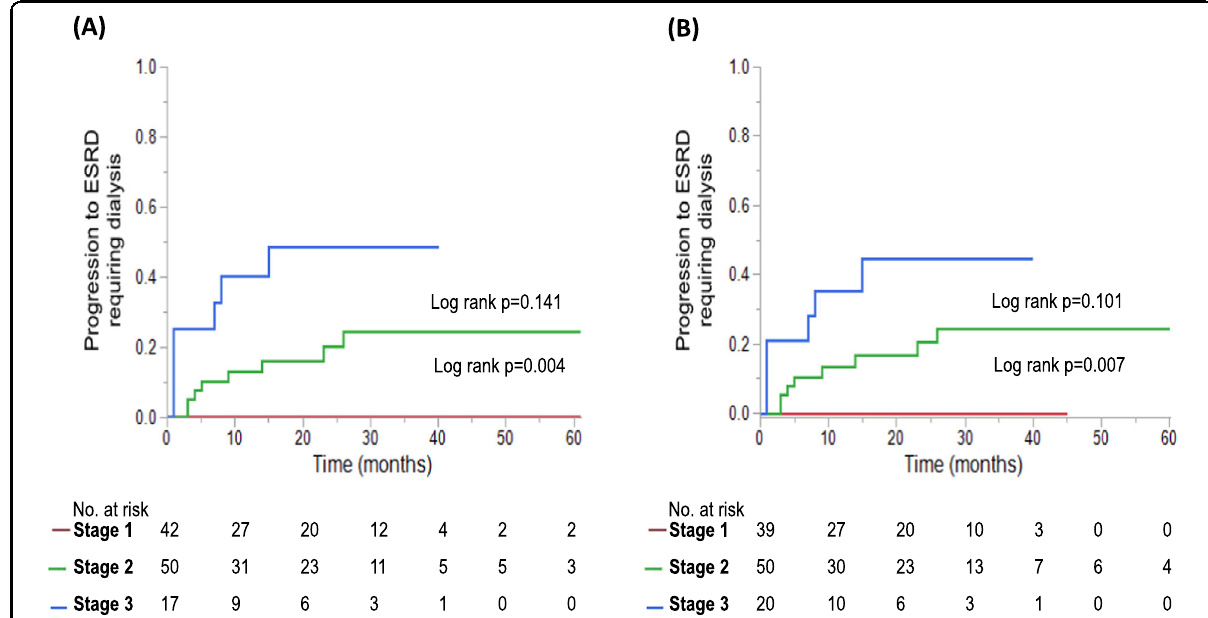
Fig. 1 Renal staging at diagnosis using either uACR or 24hUP as the measure for proteinuria. The risk of progression to end stage renal disease (ESRD) requiring dialysis is estimated with the renal staging at diagnosis. Renal stages were applied using either A 24hUP > 5000 mg, or B uACR > 3600 mg/g as the measure of proteinuria. Stage 1 is indicated in red, stage 2 in green, stage 3 in